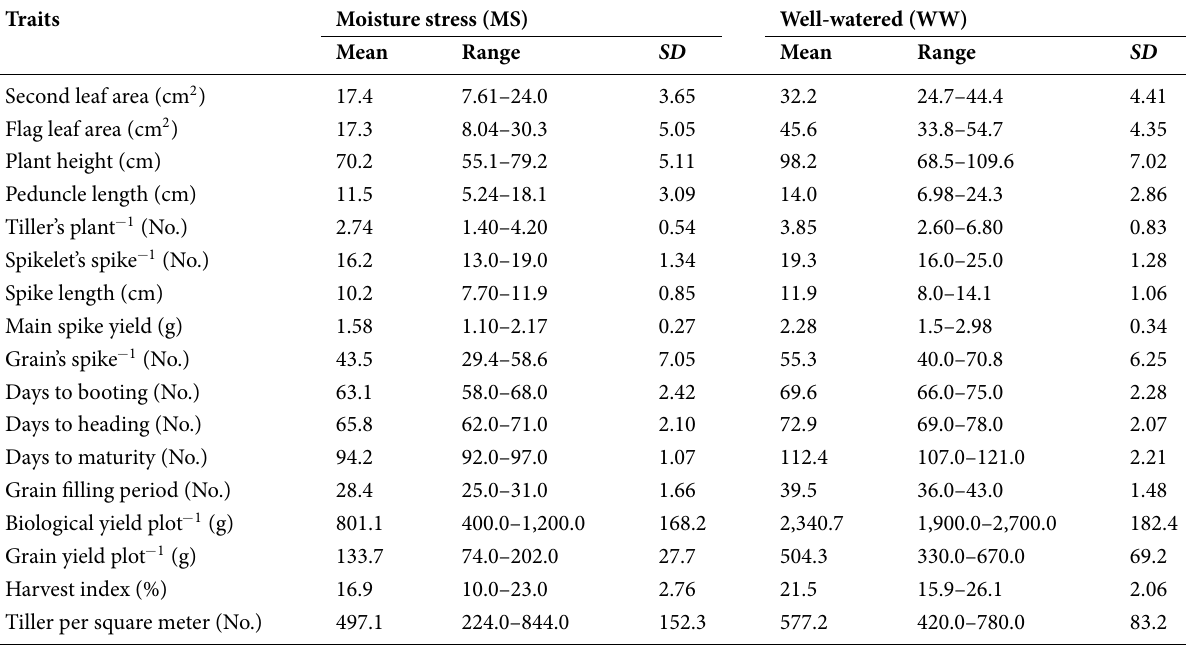
Table 4 Mean, range, and standard deviation ( SD ) of the observed agronomic traits of 36 wheat genotypes in moisture stress (MS) and well-watered (WW) conditions.